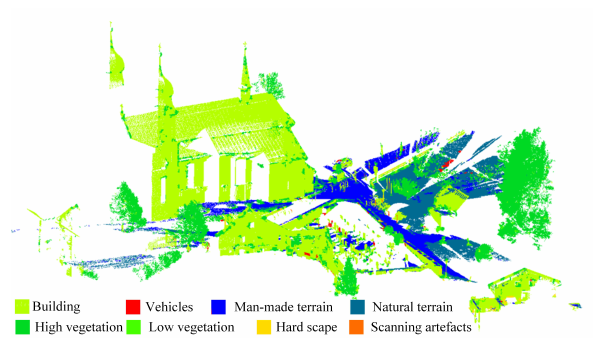
Table 4. Evaluation of using Domfountain dataset.